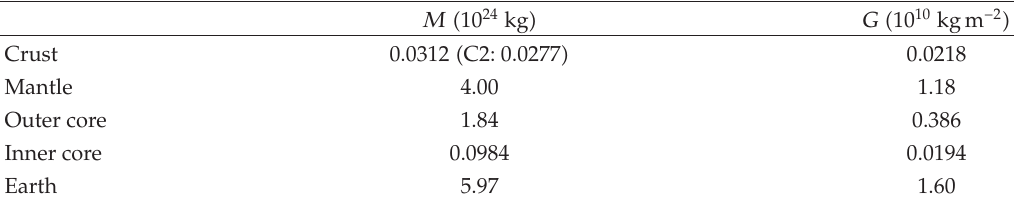
Table 5: Masses of Earth reservoirs M and geological response factors G (cid:5) 5.3 (cid:6) based on PREM (cid:3) 125 (cid:4) , where each reservoir is a spherical shell of uniform thickness. More precise crustal mass calculated using a seismically determined crustal structure (cid:5) model CRUST2.0 (cid:3) 126 (cid:4)(cid:6) is also included.